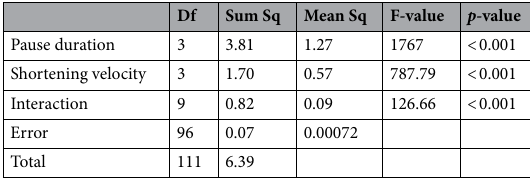
Table 2. Results of two-way ANOVA. Effects of pause duration (10, 20, 80 and 1000 ms) and shortening velocity (1/8, ½, and 2 L 0 /s) on relative